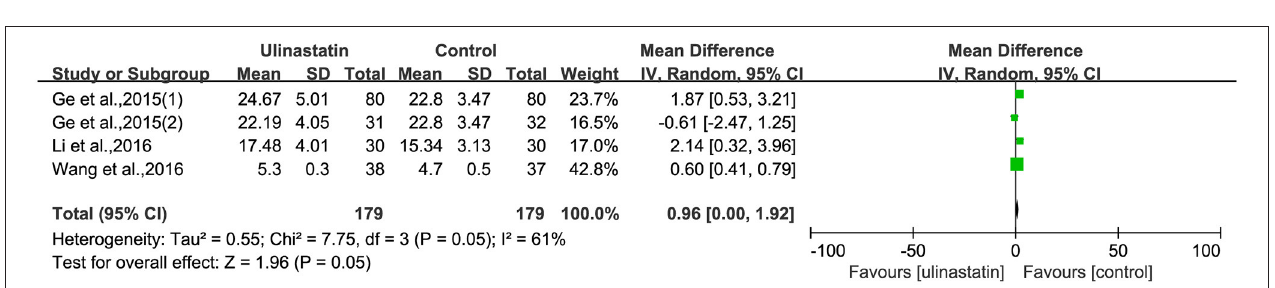
cytokines and promoting the upregulation of anti-inflammatory cytokine